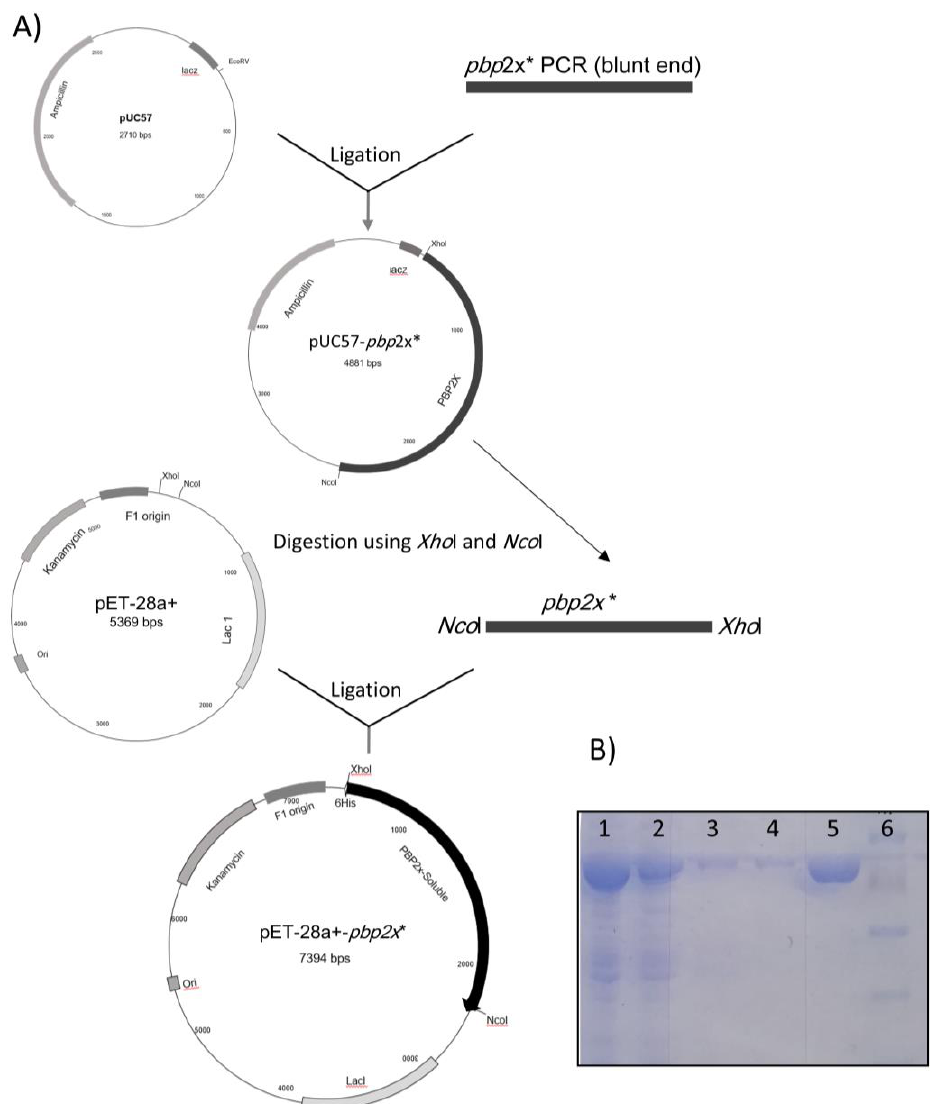
Figure 1. ( A ) Cloning of pbp 2x* (2171 bp) PCR (blunt end) into the multiple cloning sites ( EcoR V) of